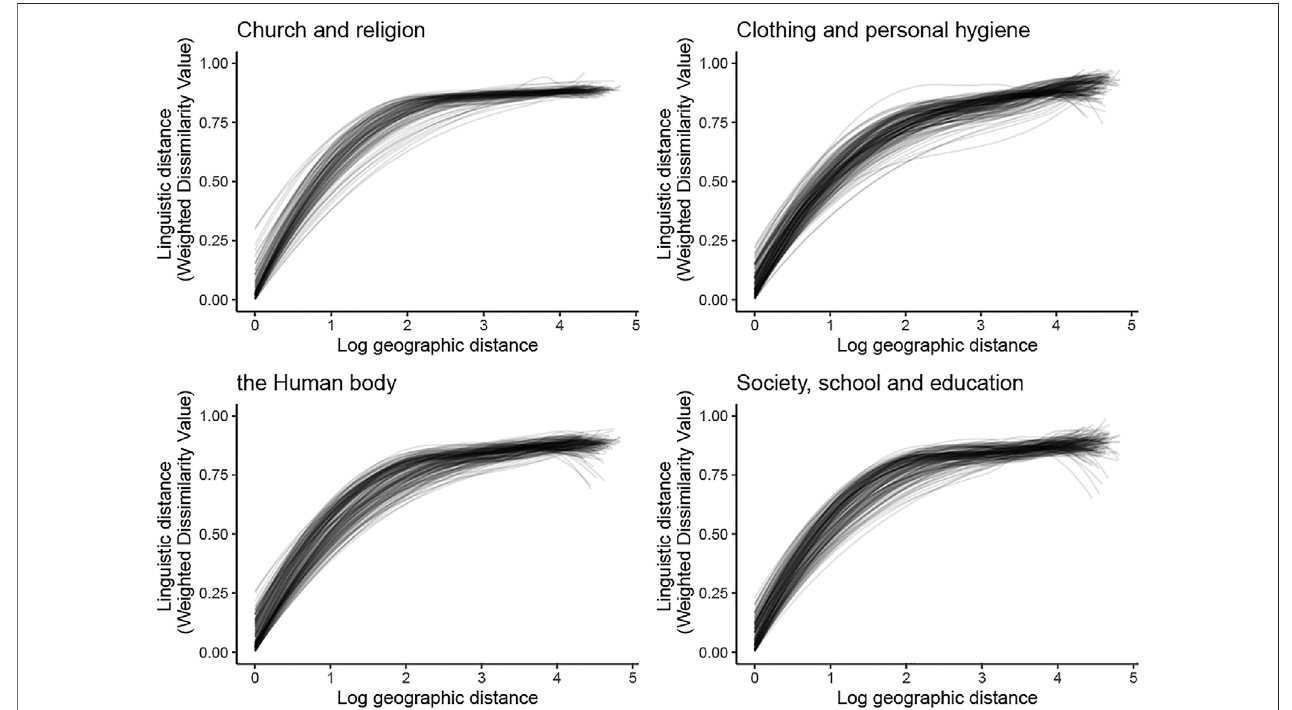
FIGURE 5 | Linguistic distance over geographic distance across four semantic domains.